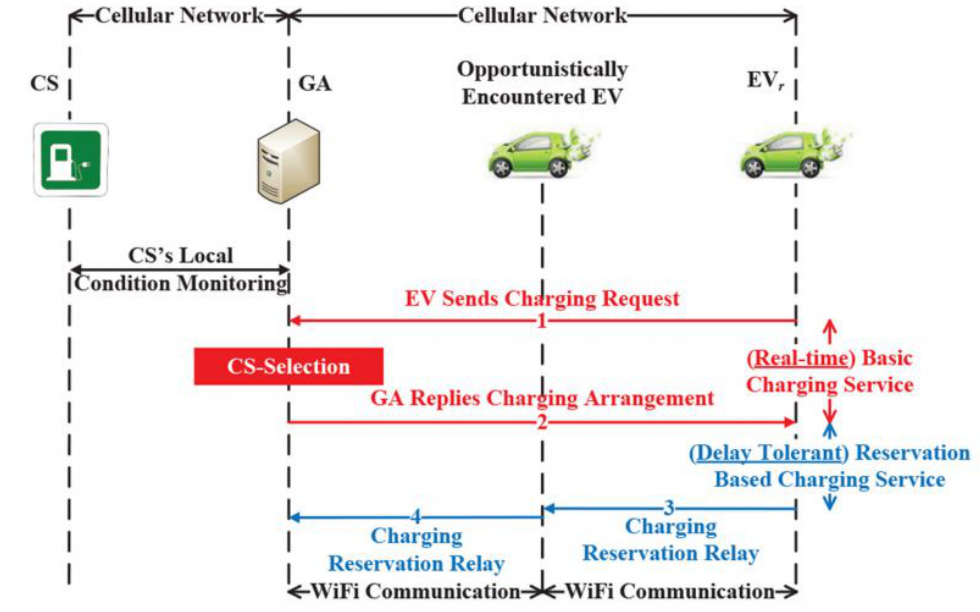
Figure 2. A sample message exchange sequence for an EV charging coordination and reservation system. ©2021 IEEE. Reprinted, with permission, from